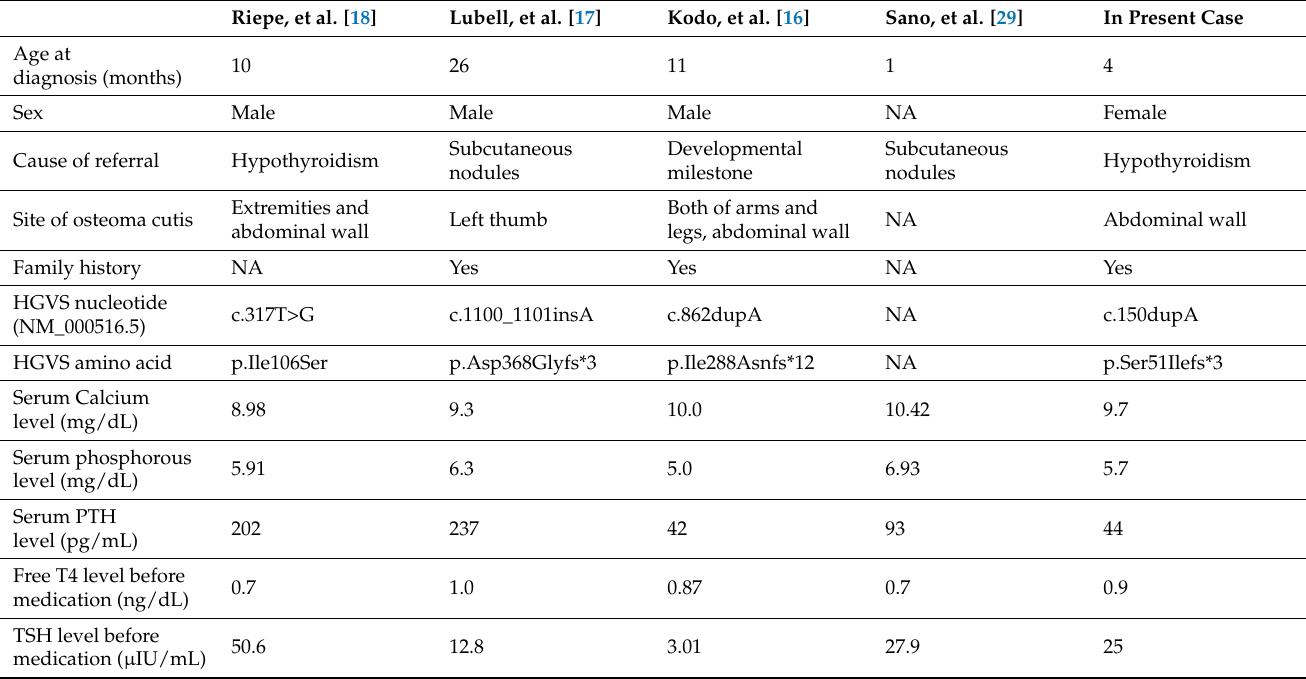
Table 1. Literature review of early diagnosed, genetically confirmed pseudohypoparathyroidism Ia before the development of hypocalcemia and related symptoms owing to osteoma cutis in young